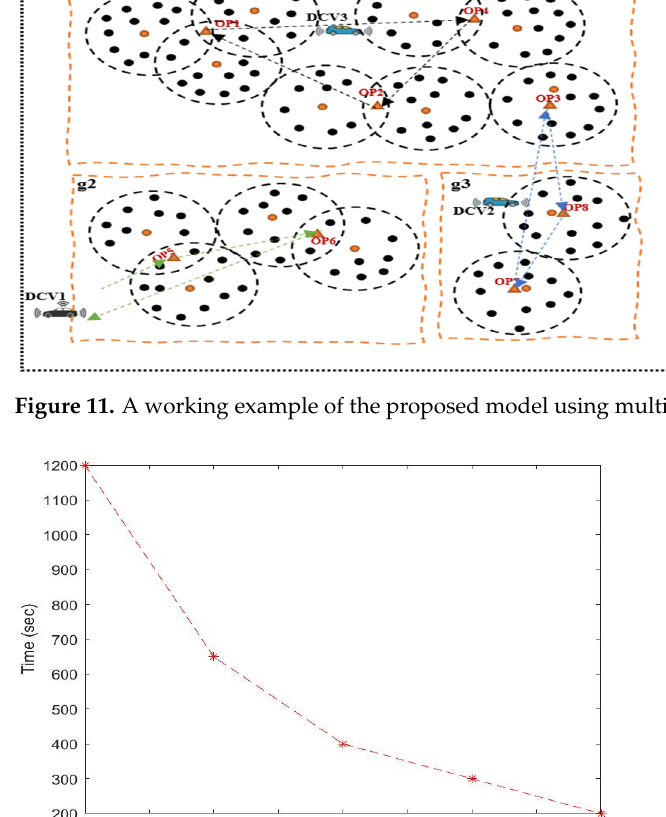
Figure 12. Maximum time usage with different numbers of DCVs from one to five.